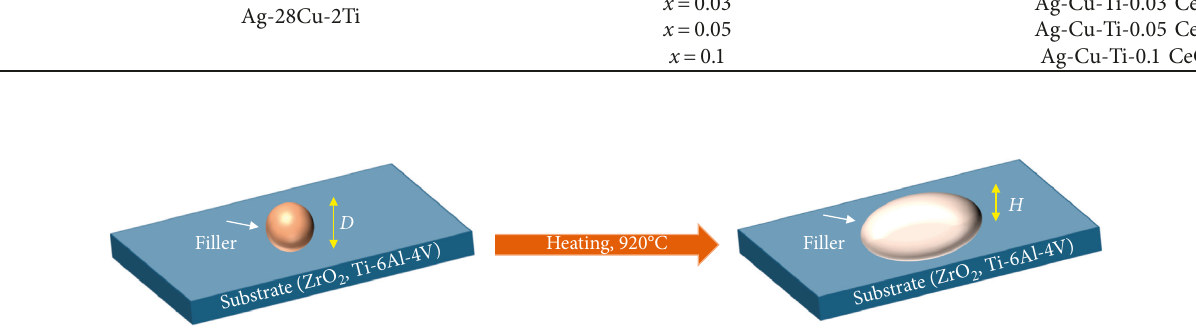
Figure 1: Schematic diagram for the measurement of brazeability.